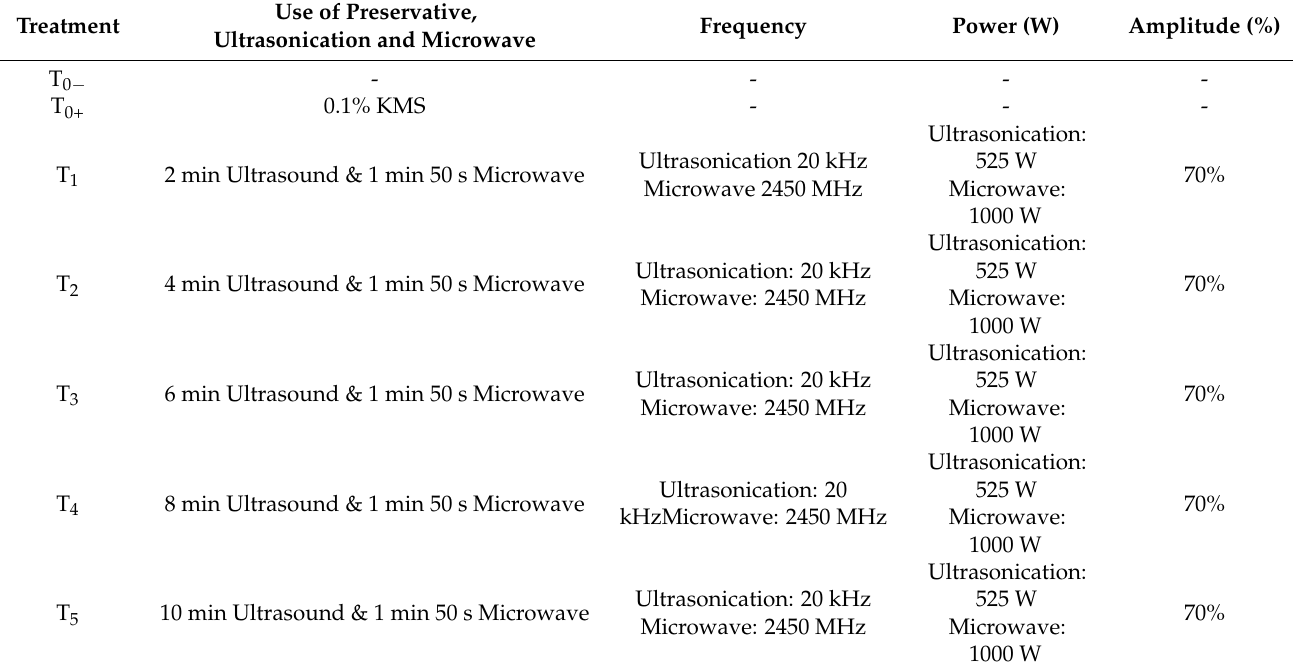
Table 1. Treatment plan for the watermelon